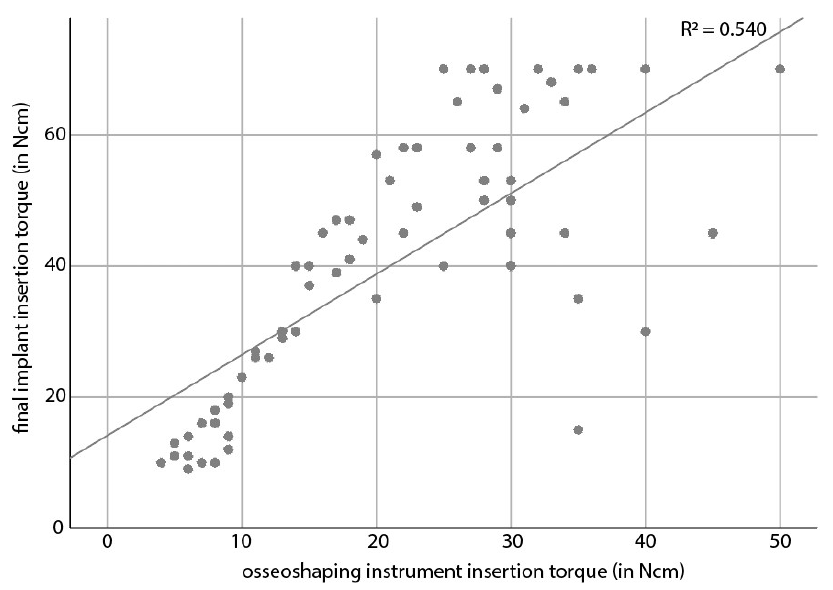
Figure 4. Correlation between the torque of the osseoshaping instrument and the final implant insertion torque.